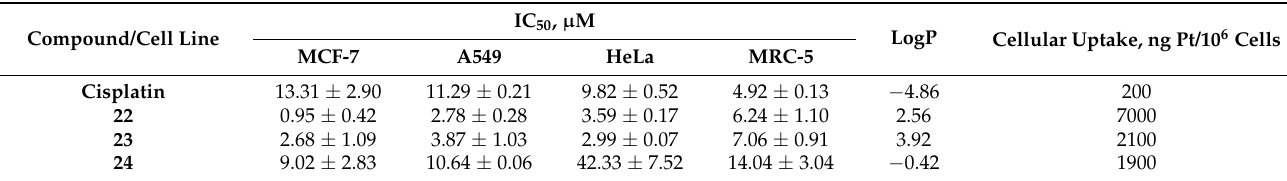
Table 11. Antiproliferative activity of cisplatin and prodrugs 22–24 on MCF-7 (breast cancer), A549 (lung carcinoma), HeLa (cervical cancer), and MCR-5 (embryo fibroblast) cell lines. LogP values and cellular uptake in MCF-7 cells are also shown.